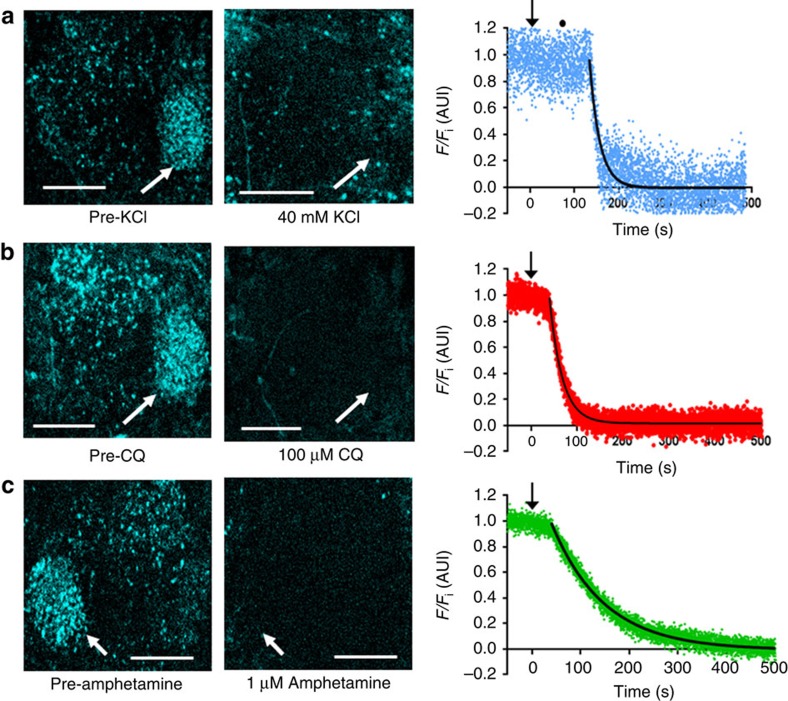
Destaining of FFN206 from dopamine terminals in TH Rescue brains.Fly brains were loaded to steady-state with FFN206 and treated with KCl, chloroquine (CQ), or amphetamine in the continued presence of FFN206. Projected image stacks of the protocerebral neuropil before (left) and after (center) treatments and kinetics of fluorescence decay in MB-MV1 region (right) from representative experiments. (a) KCl (40 mM) depolarization caused rapid FFN206 destaining in presynaptic dopamine nerve terminals. Fluorescence intensity is described by an initial plateau followed by a monoexponential decay (black line; for n=3 experiments, t1/2=6.42±0.60 s, R2=0.85) (b) Disrupting the synaptic vesicle pH gradient with chloroquine (100 μM) destained FFN206, and was best fit to an initial plateau followed by a monoexponential decay (black trace; for N=4 experiments, t1/2=26.57±3.73 s, R2=0.97). (c) Amphetamine (1 μM) also caused FFN206 destaining, and was best fit to an initial plateau followed by a monoexponential decay (black trace; for N=5 experiments, t1/2=66.60±17.08 s, R2=0.99). (a–c) λex=820 nm, λem=460/50 nm FWHM. Fluorescence was normalized to levels attained following FFN206 loading to steady-state with 300 nM as measured in arbitrary units of fluorescence intensity (AUI). Black arrows indicate initiation of drug addition (also containing 300 nM FFN206) and the black circle in a represents the point at which 50% of drug reaches the imaging chamber. Scale bar, 25 μm.